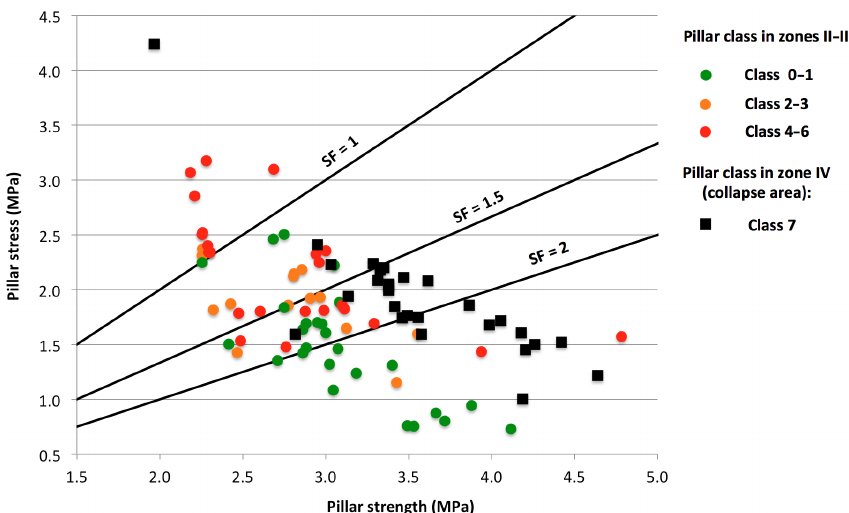
Figure 6. Pillar stress and pillar strength for pillars of different pillar classes in zones II–III and zone IV.